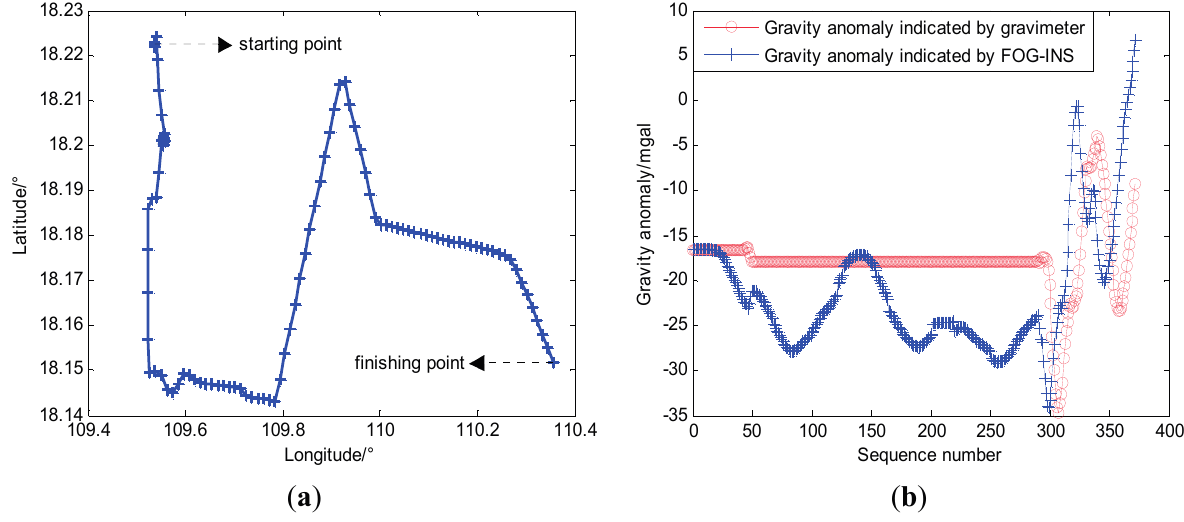
Figure 18. ( a ) True navigation trajectory indicated by PHINS; ( b ) Gravity anomalies from gravimeter and FOG-INS.